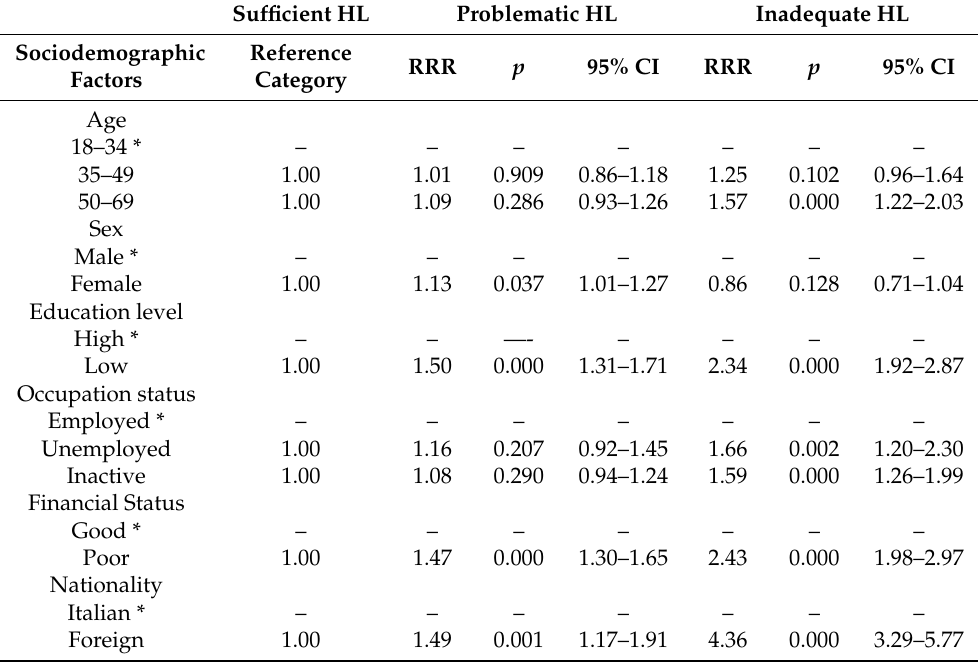
Table 2. Multinomial logistic regression analysis: association of health literacy level with sociodemo- graphic factors; RRR: Relative Risk Ratio; CI: Confidence Interval; HL: Health Literacy. Sufficient HL Problematic